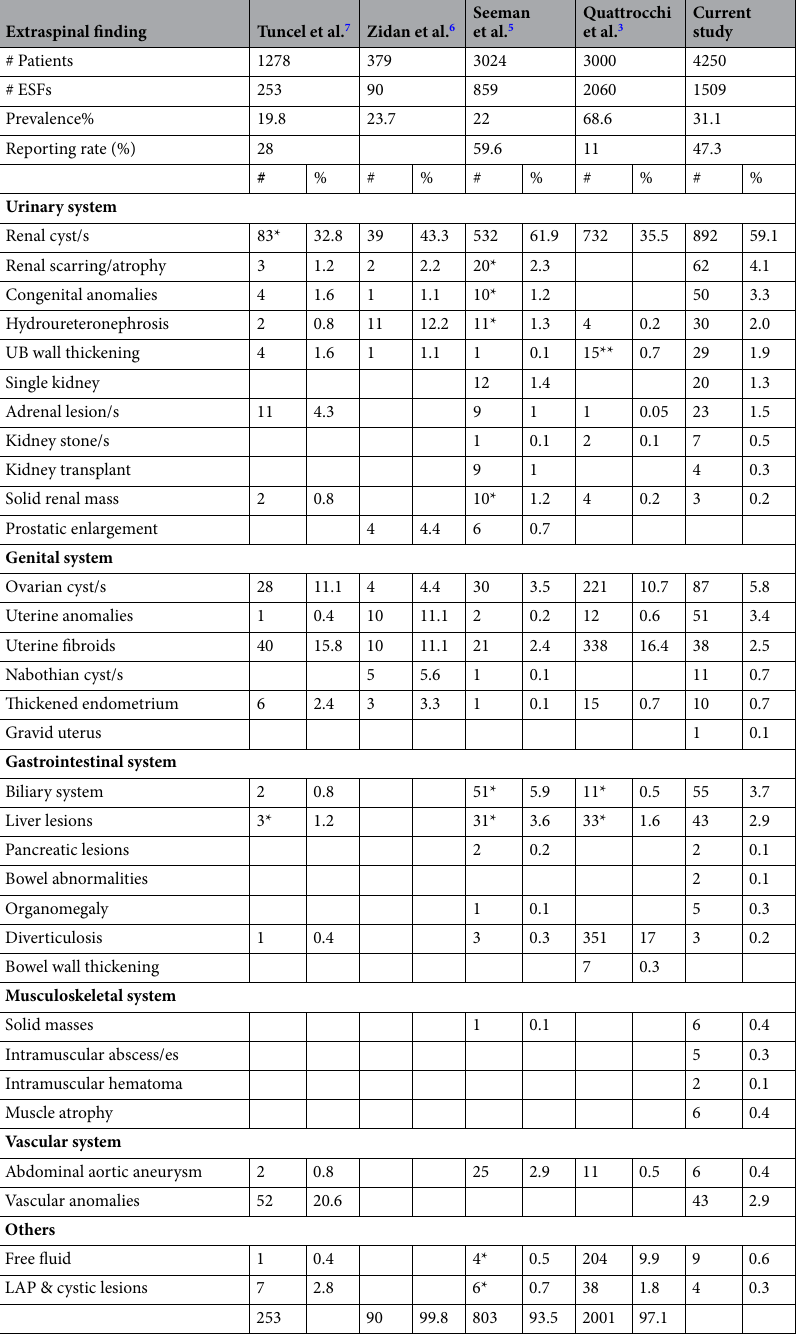
Table 4. Summary of ESFs reported in previous series. # Number, ESFs extraspinal findings. %: percentage, UB urinary bladder, LAP lymphadenopathy. *Findings were summed up based on our clinical diagnosis. **Included prostatic lesion per author’s classification for